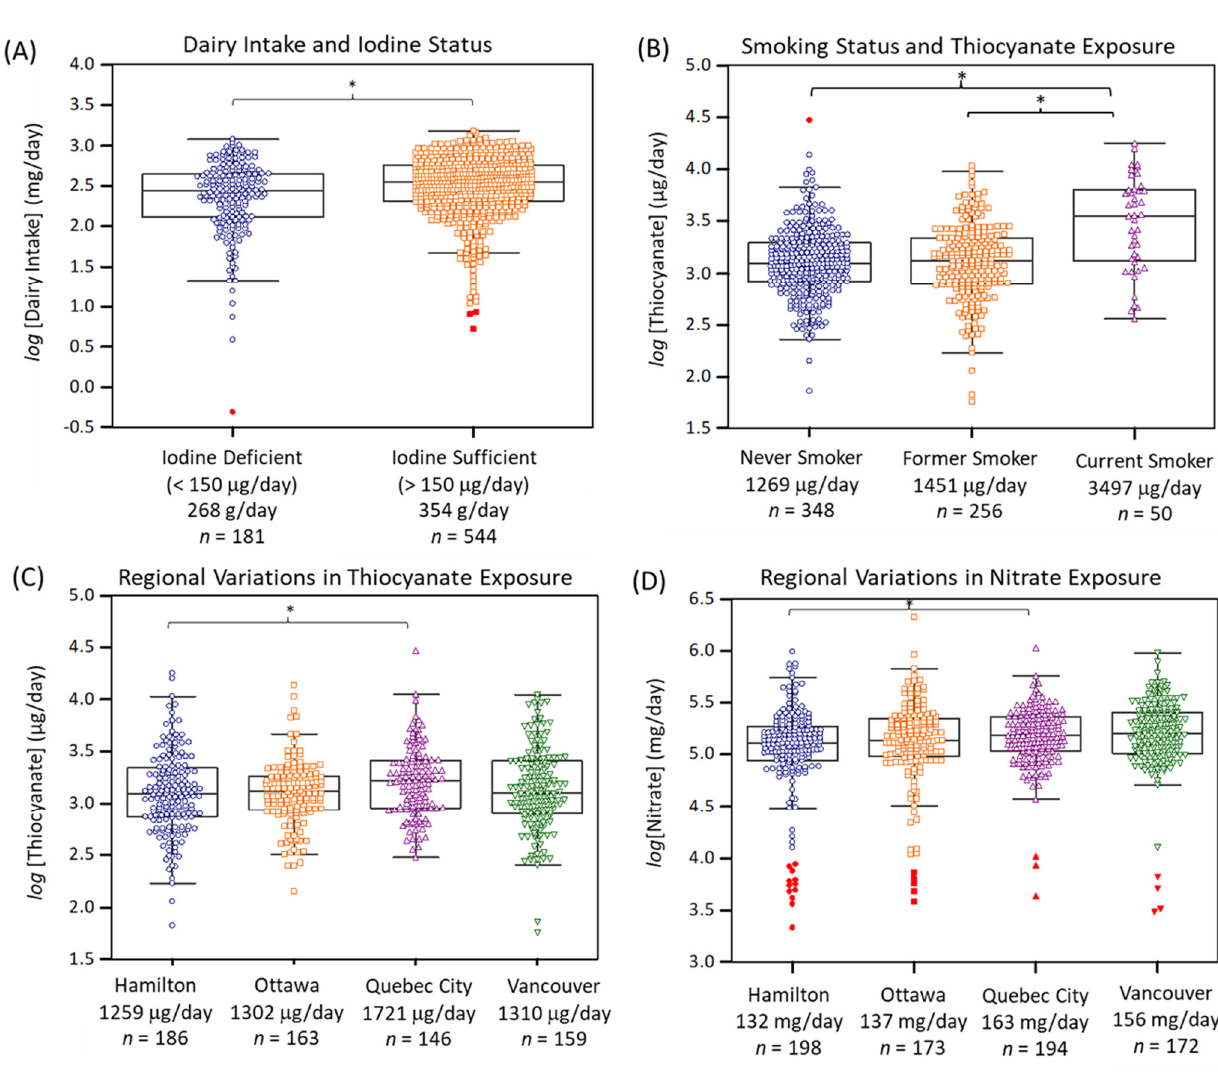
Figure 2. ( A ) Dairy intake was the most significant dietary exposure associated with iodine defi- ciency ( F = 18.7, p = 1.75 × 10 −5 , n = 725), whereas ( B ) current smoking was a lifestyle factor associated with elevated urinary thiocyanate excretion as compared to former or never smokers ( F = 19.5, p = 5.82 × 10 −9 , n = 654). Modest regional variations in exposure to environmental iodide uptake inhibi- tors, ( C ) thiocyanate and ( D ) nitrate were found. Overall, residents from Quebec City were exposed to both higher thiocyanate ( F = 3.32, p = 0.0194, n = 654) and nitrate ( F = 3.61, p = 0.0130, n = 737) relative to Hamilton when using ANCOVA after adjustment for covariates with a Bonferroni cor- rection (* p < 0.05).